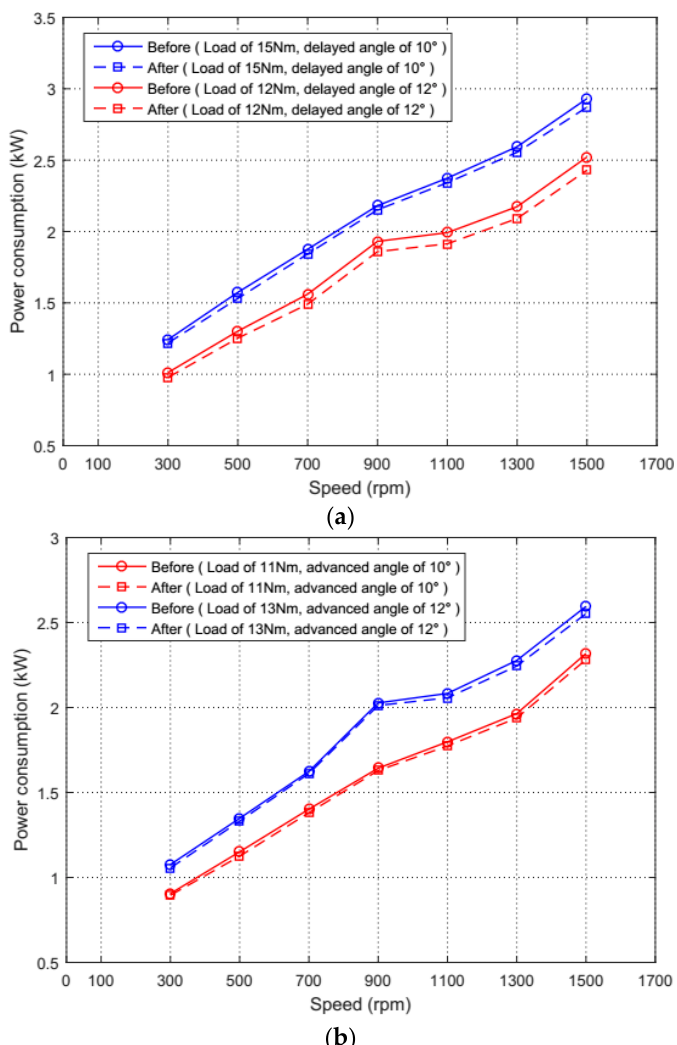
Figure 16. Power consumption comparison before and after compensation. ( a ) Under delayed commutation; ( b ) Under advanced commutation.